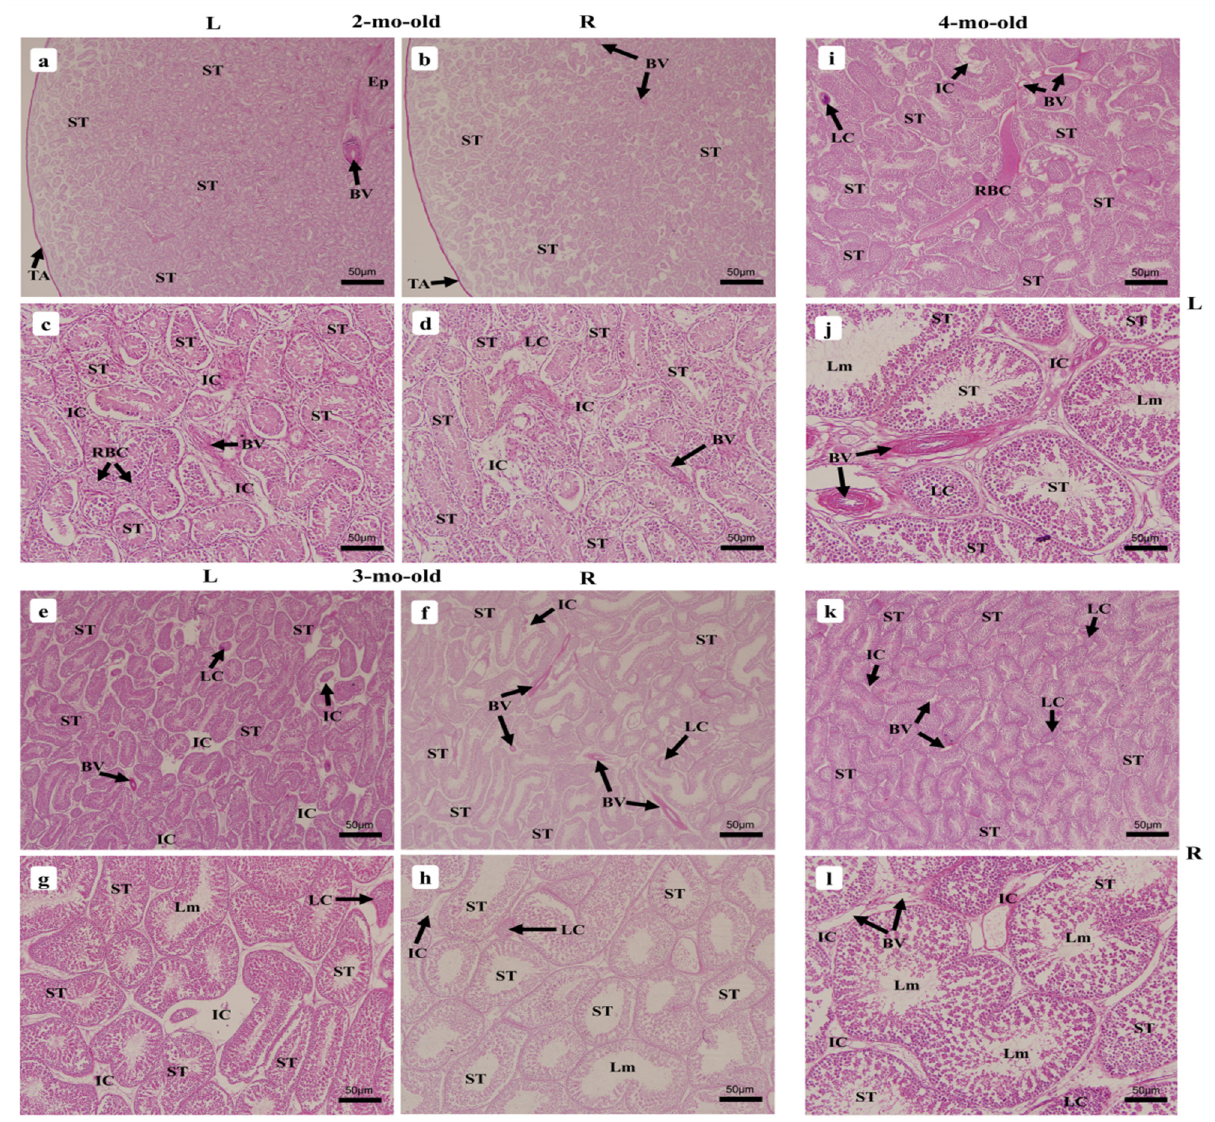
Figure 8. Histological micrographs of chicken testes during growth from 2-mo-old to 4-mo-old. ( a , b , e , f , i , k ) 40× magnification, ( c , d , g , h , j , l ) 200× magnification. ( a – d ) 2-mo-old; ( e – h ) 3-mo-old; ( i – l ) 4-mo-old. Left testis (L), right testis (R), tunica albuginea (TA), seminiferous tubules (ST), blood vessels (BV), intertubular compartments (IC), avian red blood cells (RBC), Leydig cells (LC), lumen (Lm).